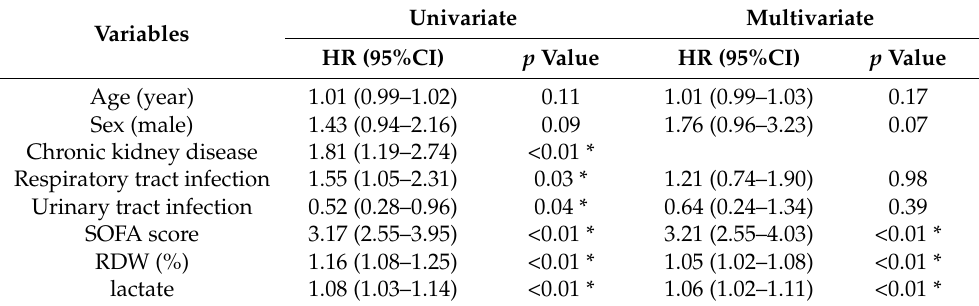
Table 3. Univariate and multivariate logistic regression models of factors associated with 30-day in-hospital mortality in patients with sepsis ( n =